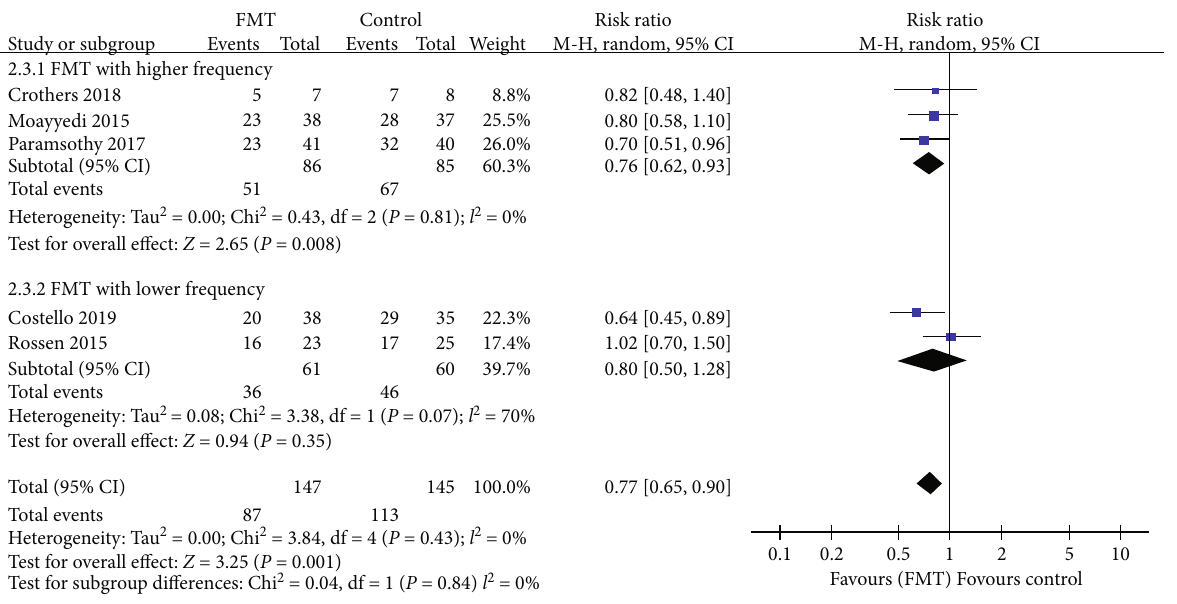
Figure 8: Forest plot of studies reporting clinical remission and subgroup analysis according to frequency of FMT